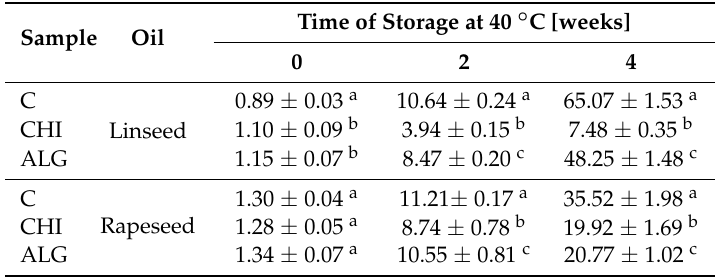
Table 2. Comparison of the change of the content of primary oxidation products in non-encapsulated and encapsulated rapeseed and linseed oil during four weeks of storage at 40 ◦ C (C—non-encapsulated oil, CHI—oil encapsulated with chitosan, ALG—oil encapsulated with sodium